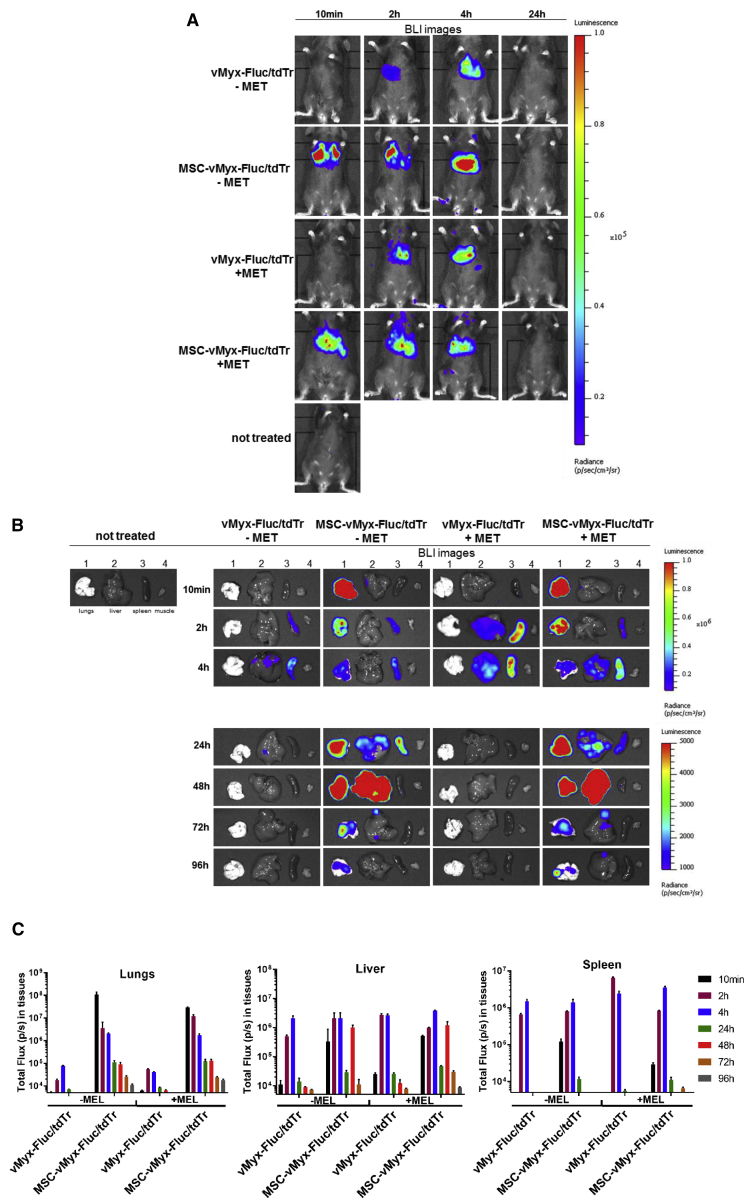
Effect of Systemically Injected MYXV Construct on Biodistribution in Mice(A and B) Bioluminescence imaging (BLI) of unchallenged (−MEL) and lung melanoma-bearing (+MEL) mice at various time points post-injection of MSC-shielded (MSC-vMyxFluc/tdTr) or unshielded reporter MYXV construct (vMyxFluc/tdTr). (A) Intact mice; (B) dissected organs (1, lungs; 2, liver; 3, spleen; and 4, muscle). BLI was expressed as radiance (photons/s/cm2/sr). Different radiance scales are shown to cover the whole span of bioluminescence. (C) ROI-based analysis of photon flux in dissected tissues (n = 3). The data represent mean ± SD of two independent experiments.